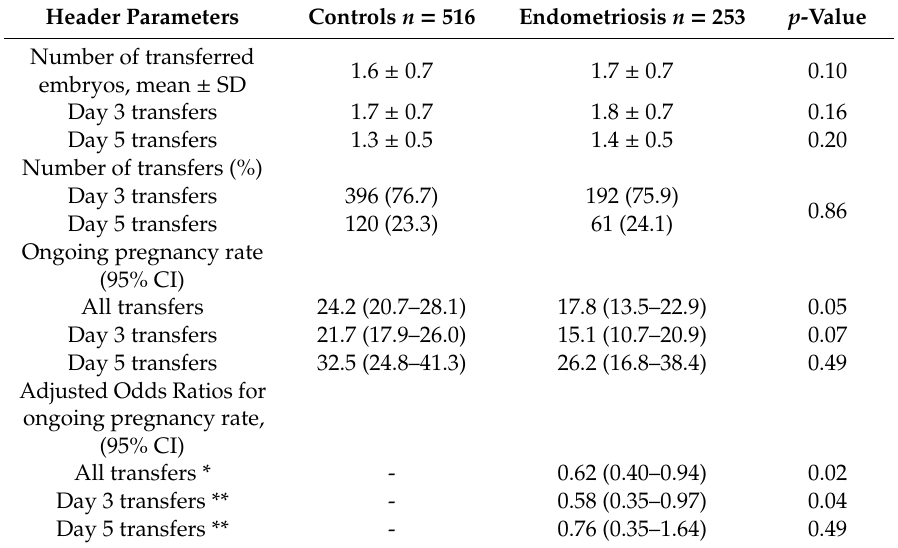
Table 3. Embryo transfer details and ongoing pregnancy